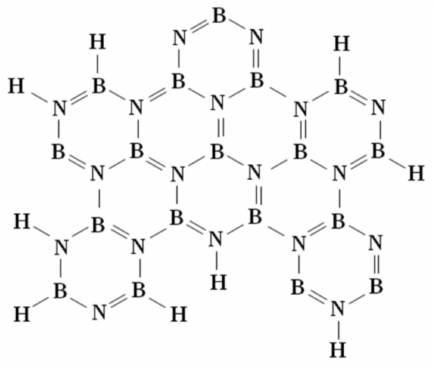
Figure 1. Structures of BNH x